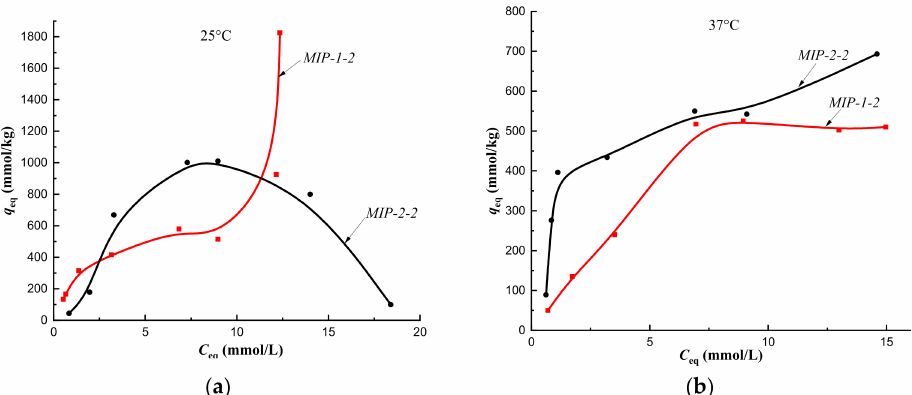
Figure 7. Isotherms of sorption of cholesterol on CP-1 and CP-2 at a temperature of 25 ◦ C ( a ) and at a temperature of 37 ◦ C ( b ) (fraction 160–315 µ m).